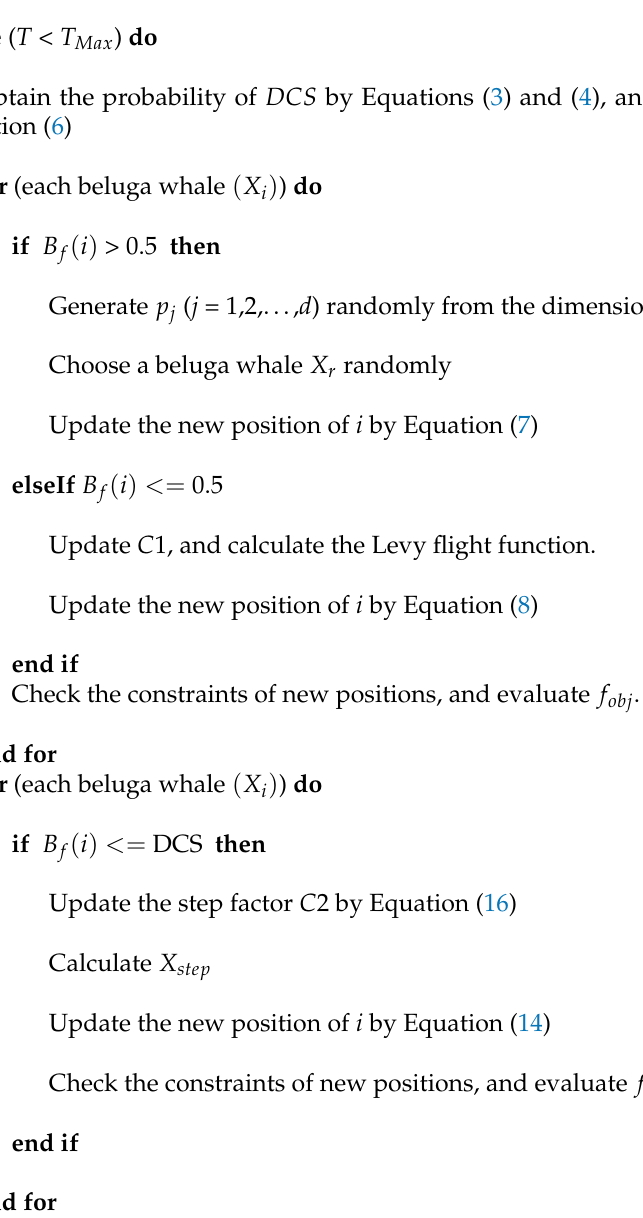
Algorithm 1 The pseudo-code of the proposed OBWOD